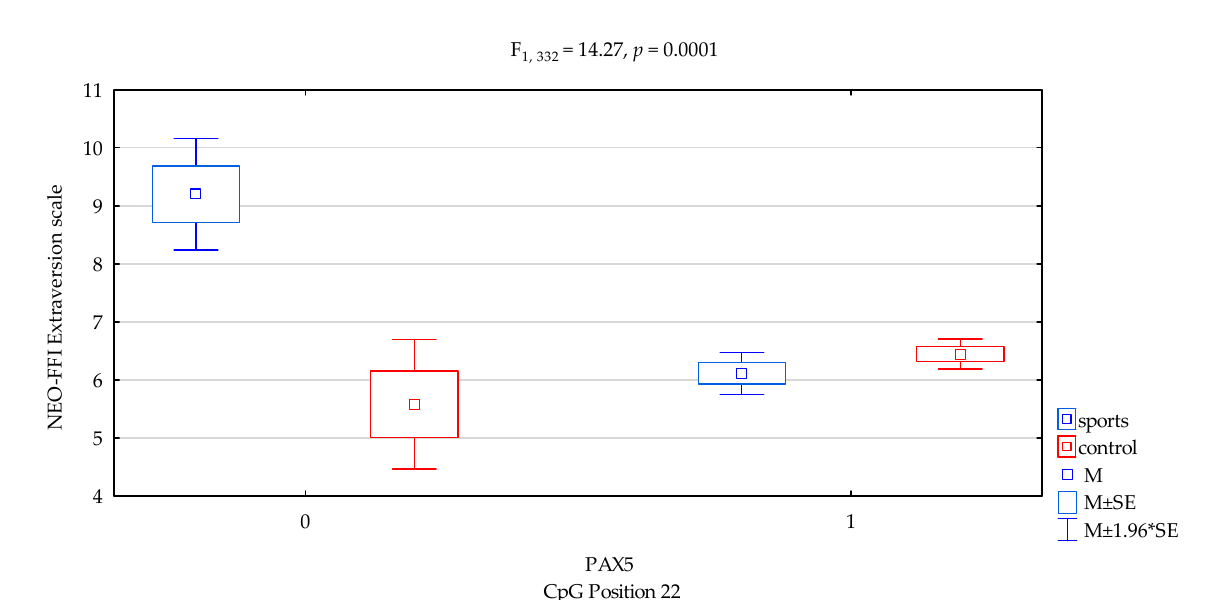
Figure 4. Interaction between sports subjects/control and DAT1 PAX5 CpG sites 22 and NEO FFI Extraversion scale. Methylation status: yes—1, no—0. M ± SE—mean ± standard error, M ± 1.96*SE—mean ± s1.96*standard error.